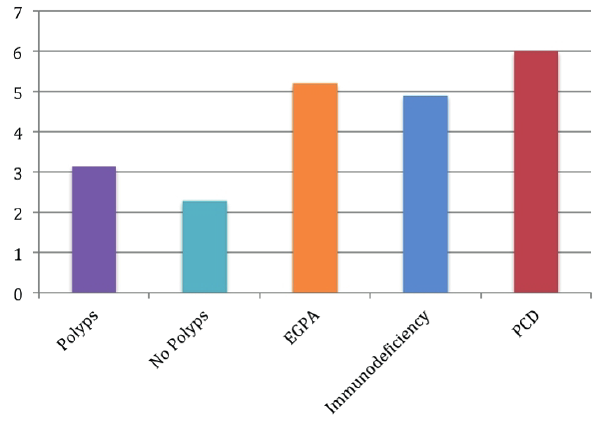
Figure 4. Mean ETDQ-7 score by diagnosis. The number of patients with each diagnosis is as follows; Polyps (CRSwNP) 69, No polyps (CRSsNP) 28, EGPA (Eosinophilic granulomatosis with polyangitis) 3, Immunodeficiency 2 and PCD (Primary ciliary dyskinesia)